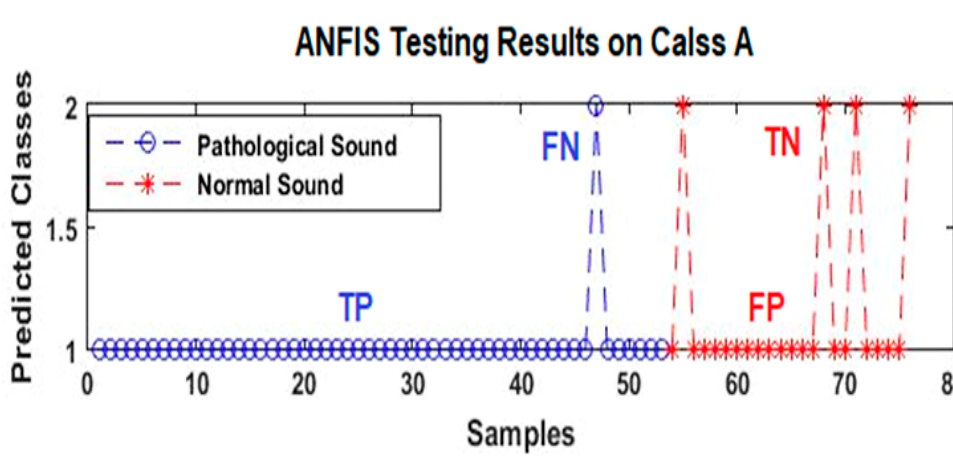
Figure 4. ANFIS testing results for class A dataset.